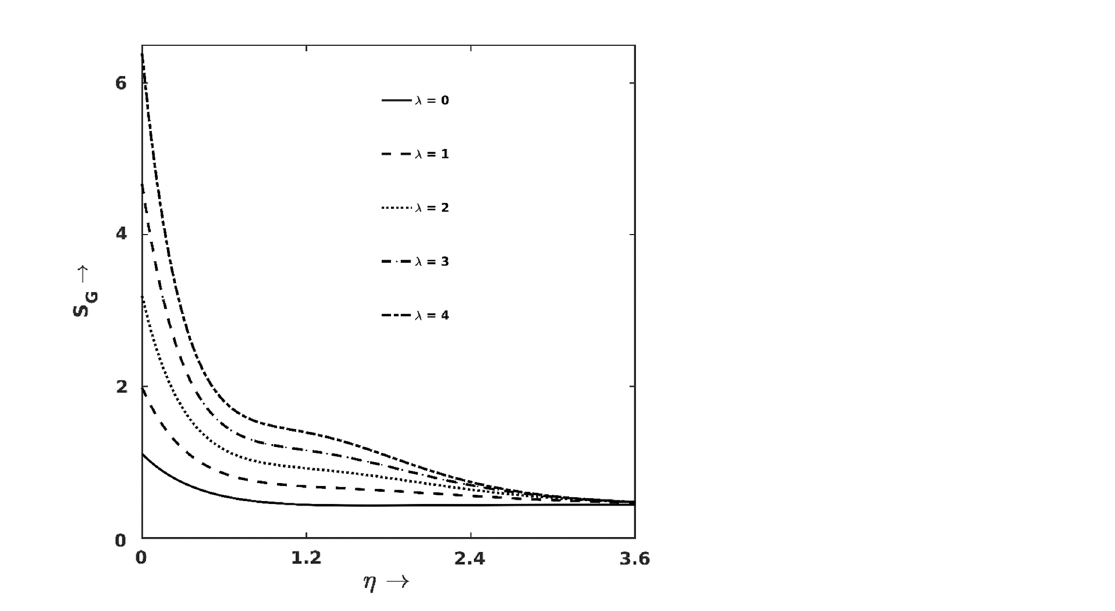
Figure 11. (cid:31) effect on S G